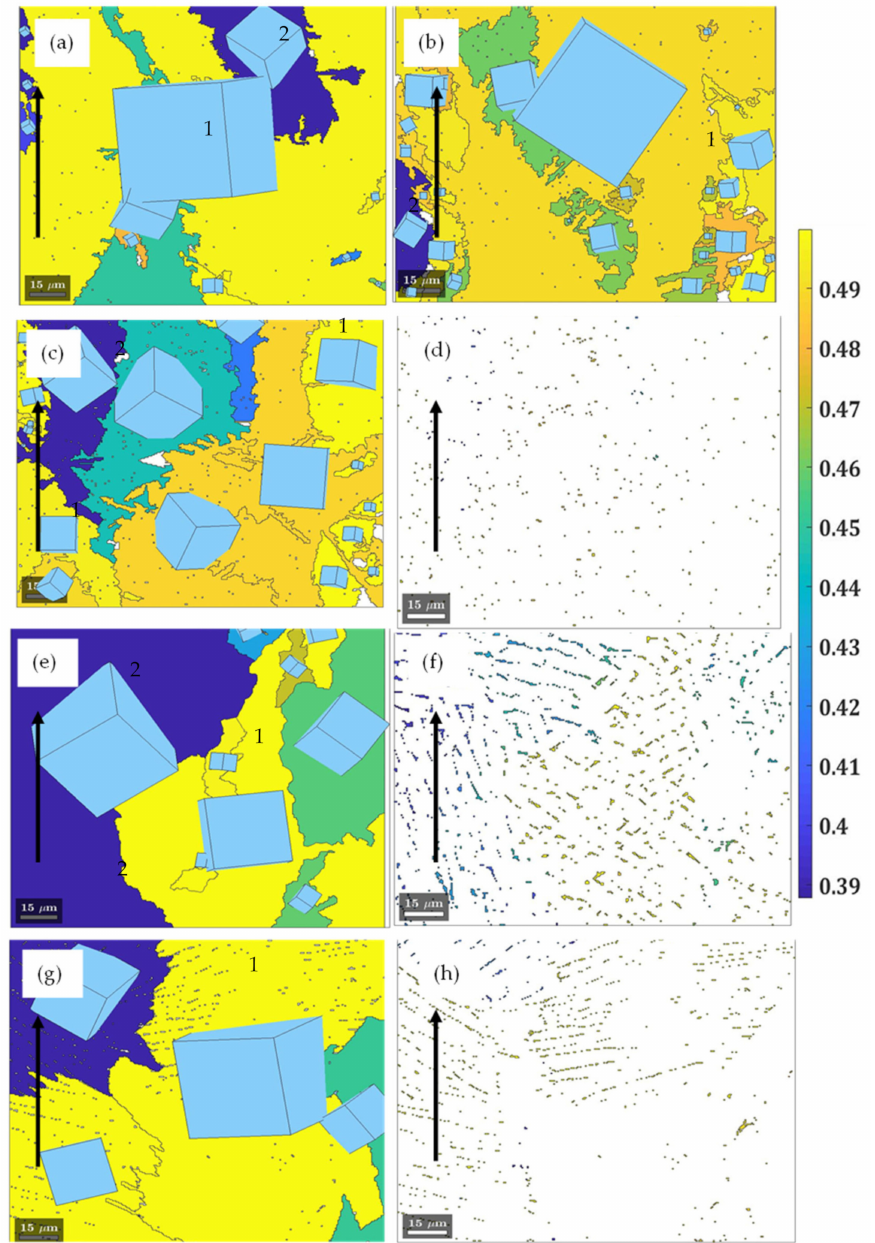
Figure 12. Typical distribution of the global Schmid factor in ( a – c , e , g ) reconstructed prior β -grains with the orientation of cubic structure shown in each grain and ( d , f , h ) retained β -grains for ( a ) samples A, ( b ) samples B, ( c , d ) samples C, ( e , f ) samples D, and ( g , h ) samples E. The black arrows indicate the build